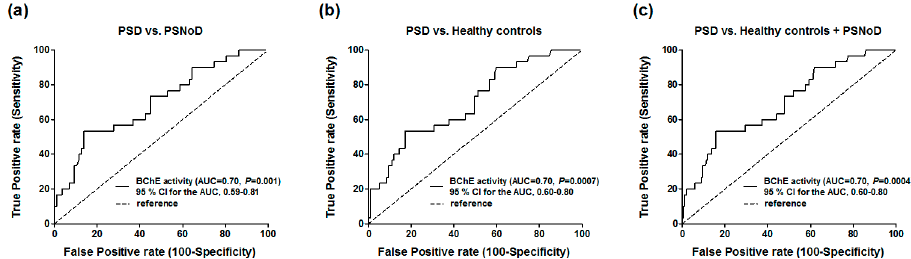
Figure 2. ROC curve with plasma BChE activity between the post-stroke dementia (PSD) and ( a ) the post-stroke patients without dementia (PSNoD), ( b ) healthy controls or ( c ) healthy controls + PSNoD. AUC, Area under the curve. CI, Confidence interval.